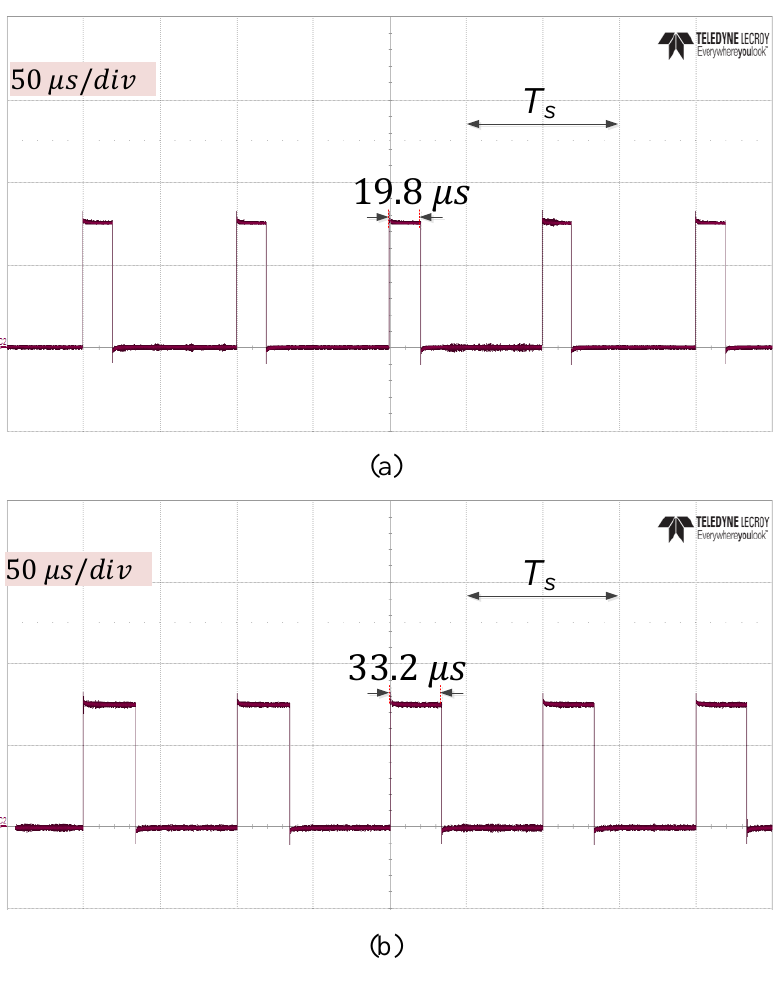
Figure 11. Computation burden. ( a ) UFCS-PTC, ( b ) MSPTC.